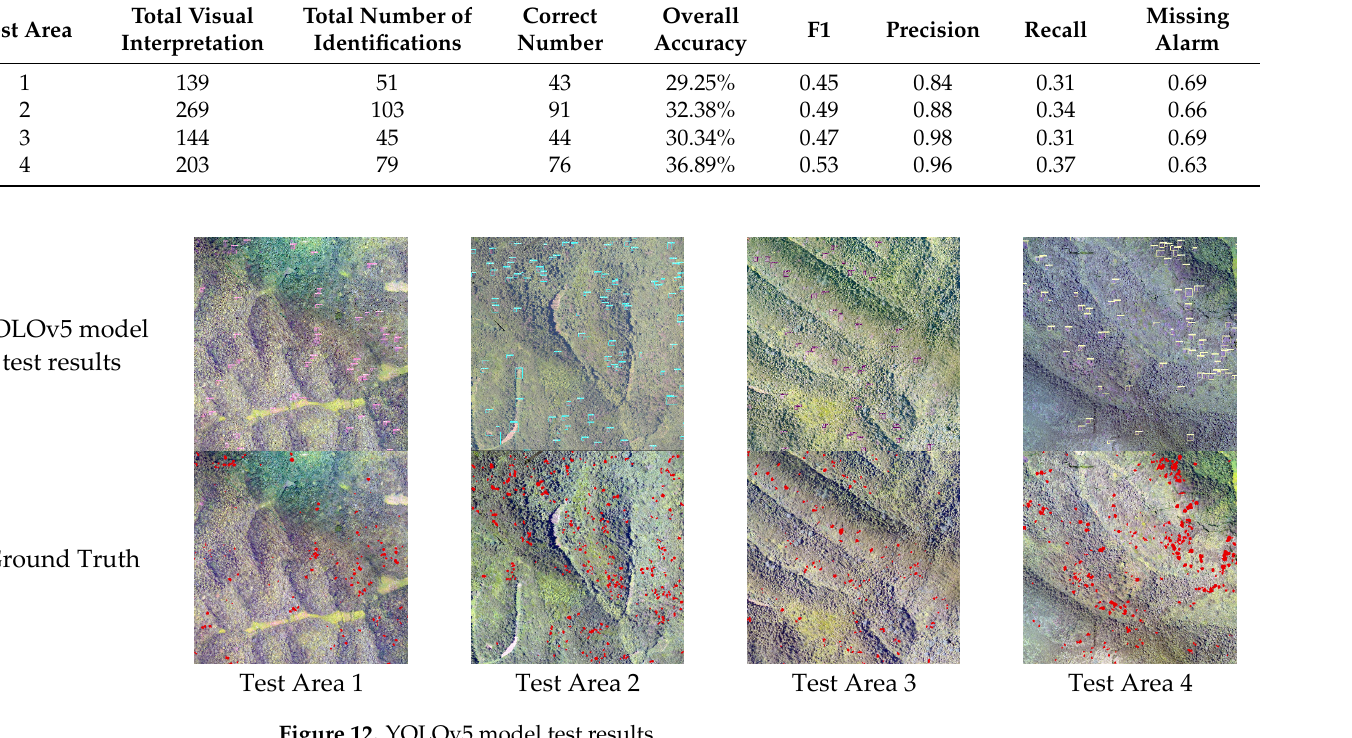
Figure 12. YOLOv5 model test results. Table 4. The accuracy identification using